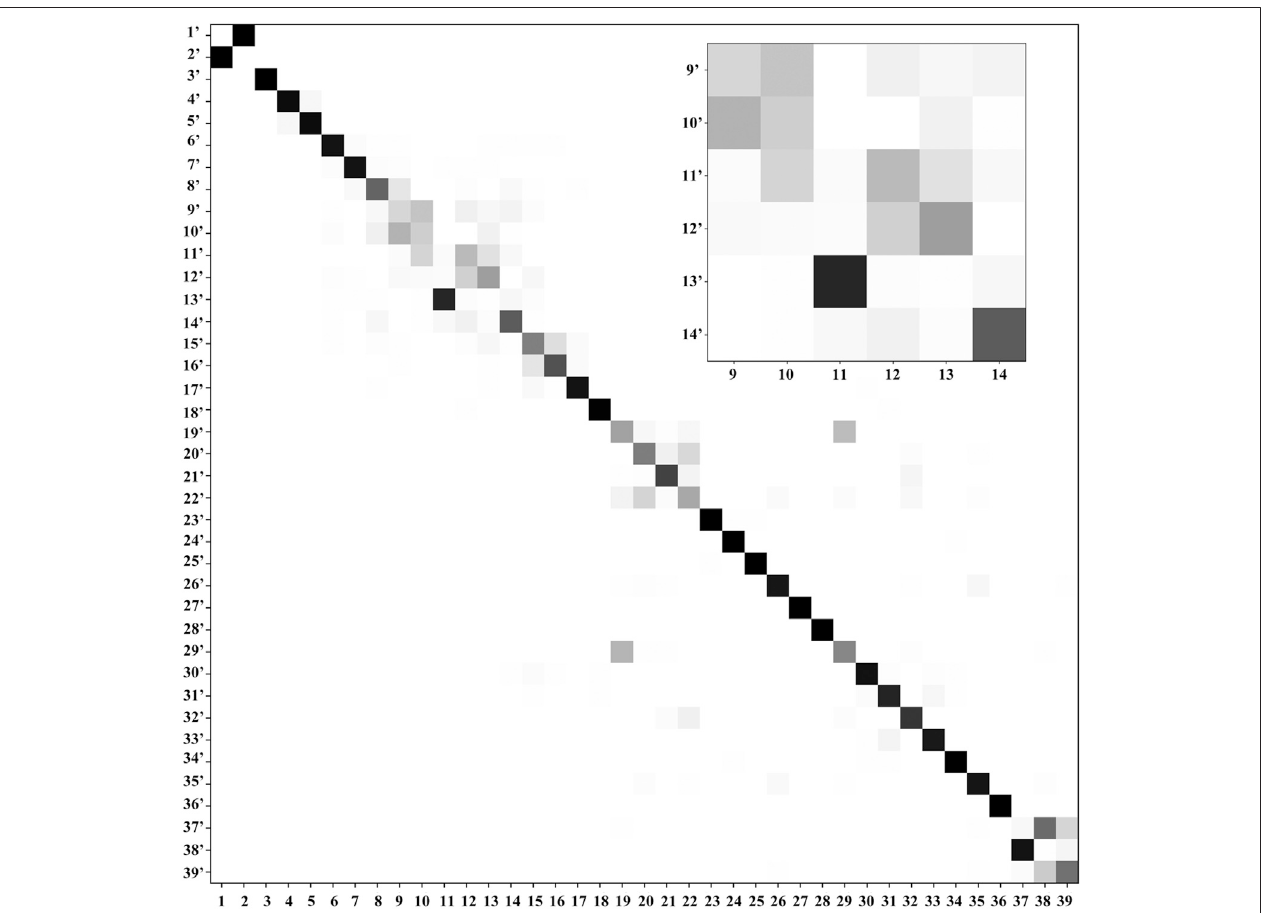
FIGURE 4 | Duschinsky matrix: the normal coordinates of the fi nal state T + (columns) are expressed in the basis set of the normal coordinates of the initial state T (rows). A gray scale is used to represent the magnitude of each element of the J matrix, with a white square for a near-null value and a black square for 1 (equivalent normal modes). The part with largest mode coupling is shown in the Figure 5 and Table 2 . The peak at 1672 cm − 1 - 1674 cm − 1 corresponds to two transitions, of which one is the combination 21 1 19 1 [ β (N 3 H), β (C 6 H), β (C 5 -CH 3 ), δ (ring); β (C β (CH δ (ring) β (N 1 30 1 [ γ 3 H), 6 H), 3 )] and the other is the 31 (C 5 -CH 3 ), γ (NH), γ (CH), τ (ring); ( γ (C 6 H), γ (CH 3 )] involved